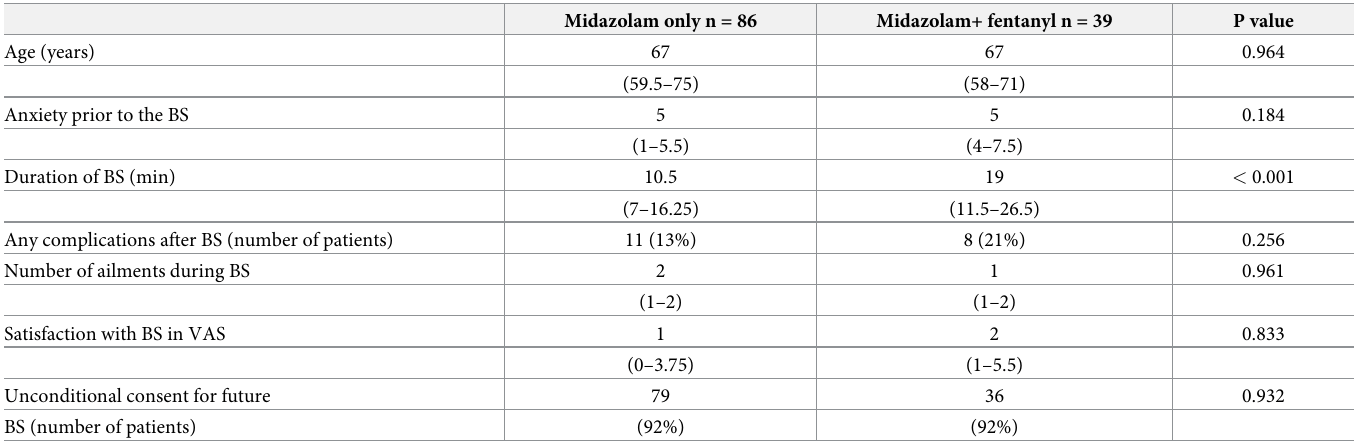
Table 2. Differences between different types of